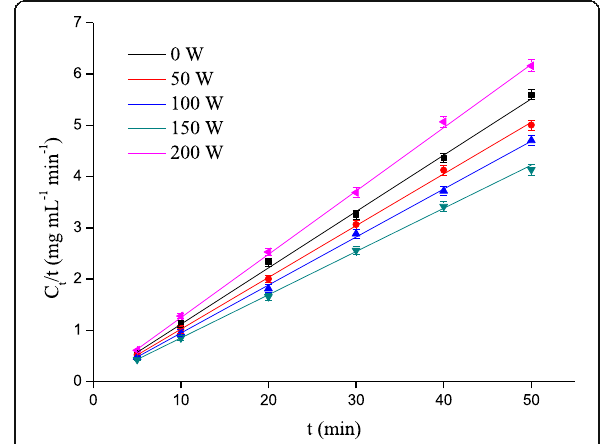
Fig. 1 Effect of extraction time on the concentration of collagen (mg mL − 1 ) at any time t during ultrasound power carried out at liquid to solid ratio of 20 mL g − 1 and pepsin (2000 U g − 1